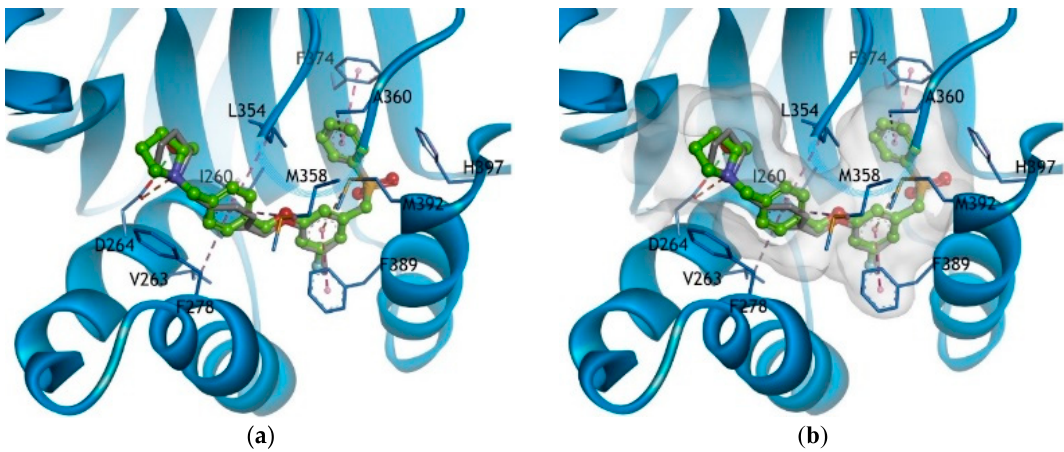
Figure 4. Docking model of 5 (light green, ball and stick model) superimposed with the x-ray binding conformation of PF-543 (gray, stick model) to SK1 (blue ribbon model) ( a ). The hydrogen bond is shown as a green dashed line, and electrostatic interactions are displayed as an orange dashed line. Moreover, the hydrophobic interactions are shown as a pink dashed line and the surface model of the active site bound to 5 is displayed ( b ). For clarity, only the key residues are visible in the stick model and are labeled using the 1-letter amino acid